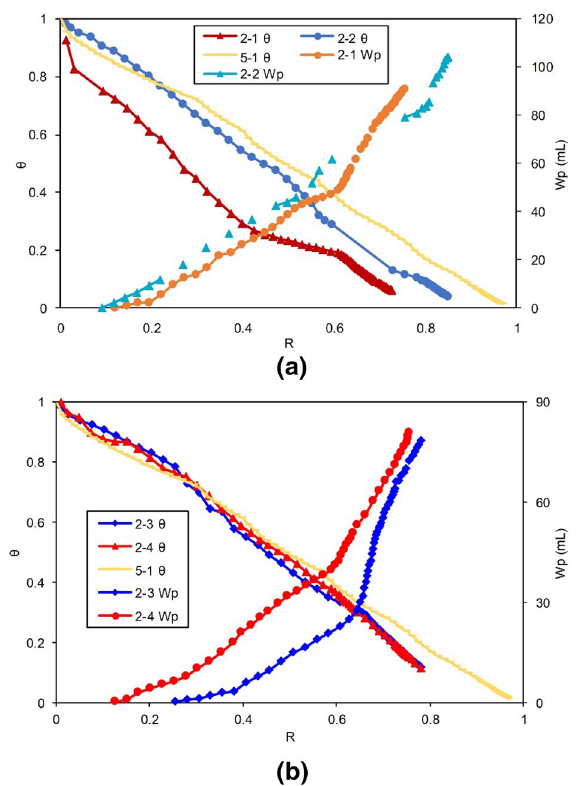
Figure 14. Relationship between relative apparent pressure of the formation and R : ( a ) drainage Experiments 2-1 and 2-2 in the LFZ, and ( b ) drainage Experiments 2-3 and 2-4 in the